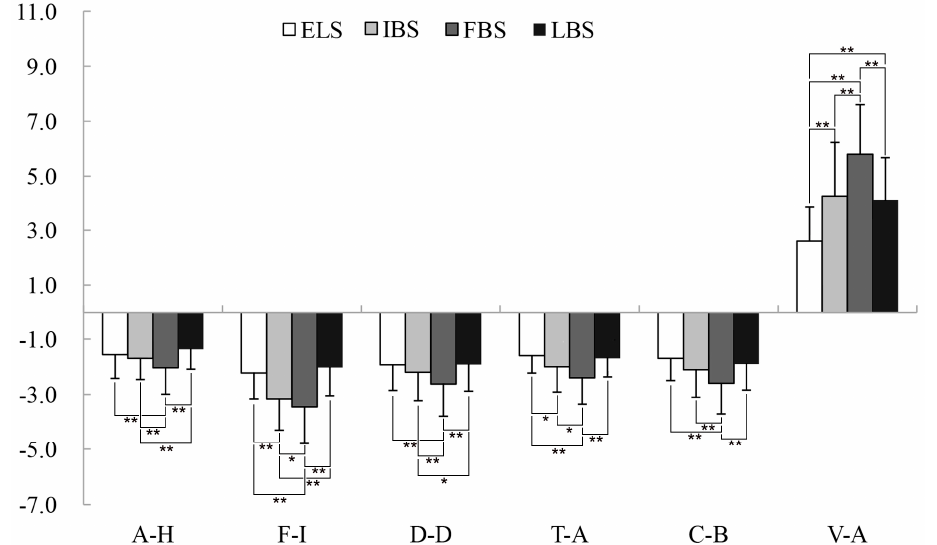
Figure 8. Comparison of POMS scores among the experimental groups. ELS: exhibition leaf stage, IBS: initial bloom stage, FBS: full bloom stage, and TBS: terminal bloom stage. A–H: anger–hostility, F–I: fatigue–inertia, D–D: depression–dejection, T–A: tension–anxiety, C–B: confusion–bewilderment, and